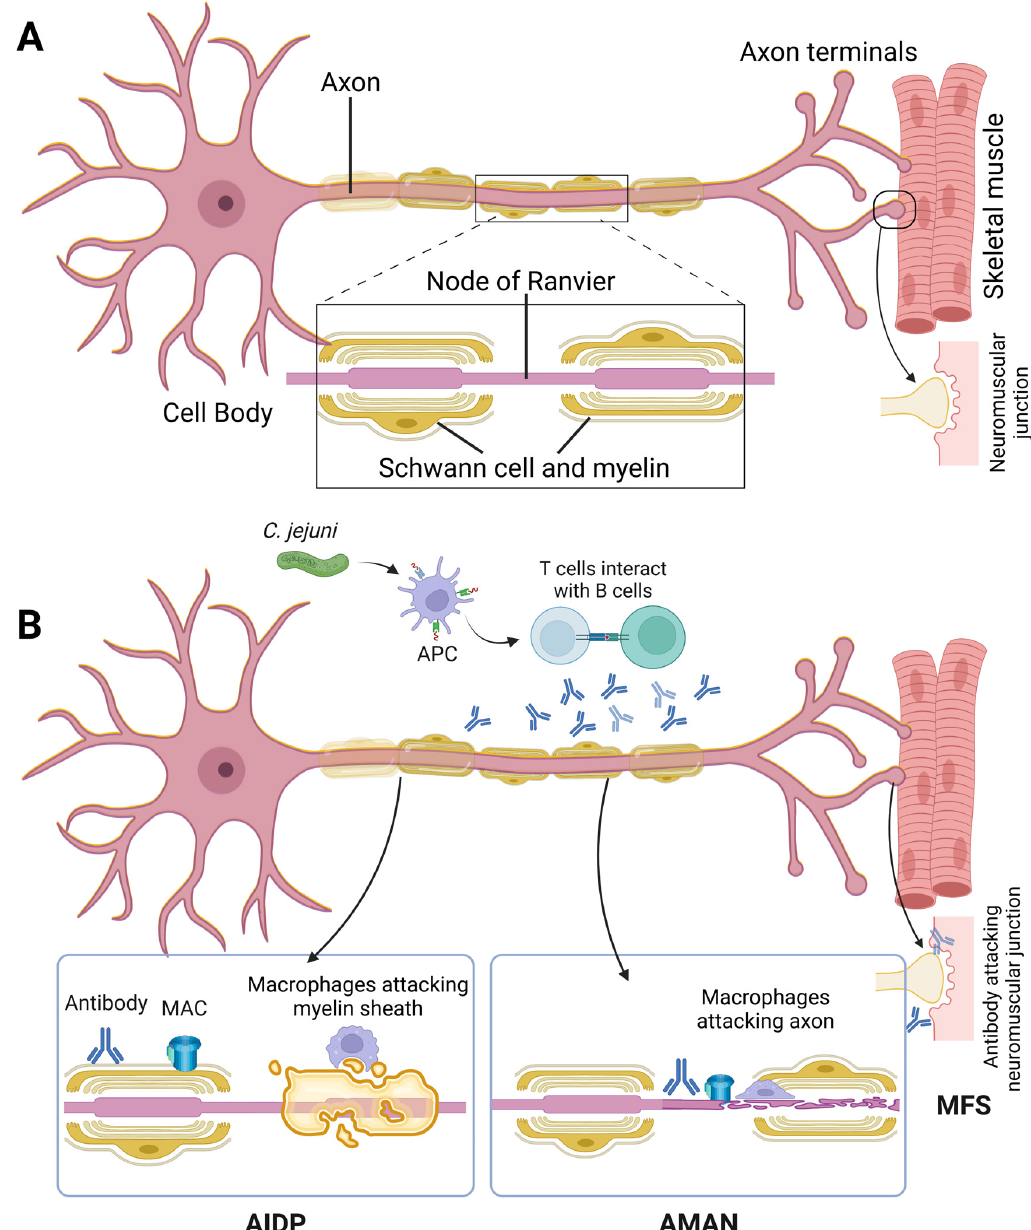
Figure 1. ( A ) A typical motor nerve is shown here. The nerve axon is covered by Schwann cells, which form the myelin sheath. This myelin sheath is discontinuous and contains gaps called as the node of Ranvier. The action potential travels from node to node. ( B ) In AIDP, the myelin sheath is affected; in AMAN and AMSAN, the axon is affected, while in MFS, the neuromuscular junction